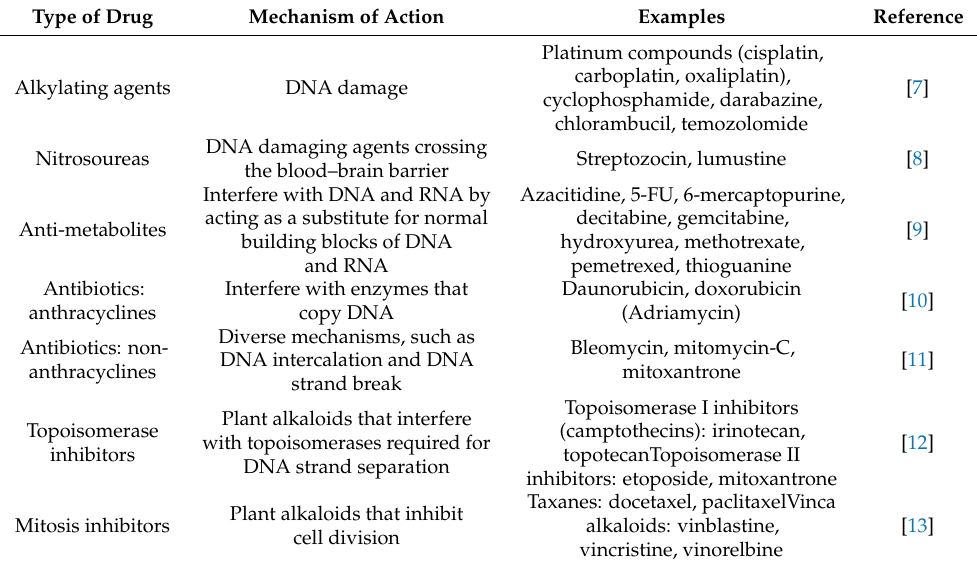
Table 1. Commonly used chemotherapeutics and their mechanisms of